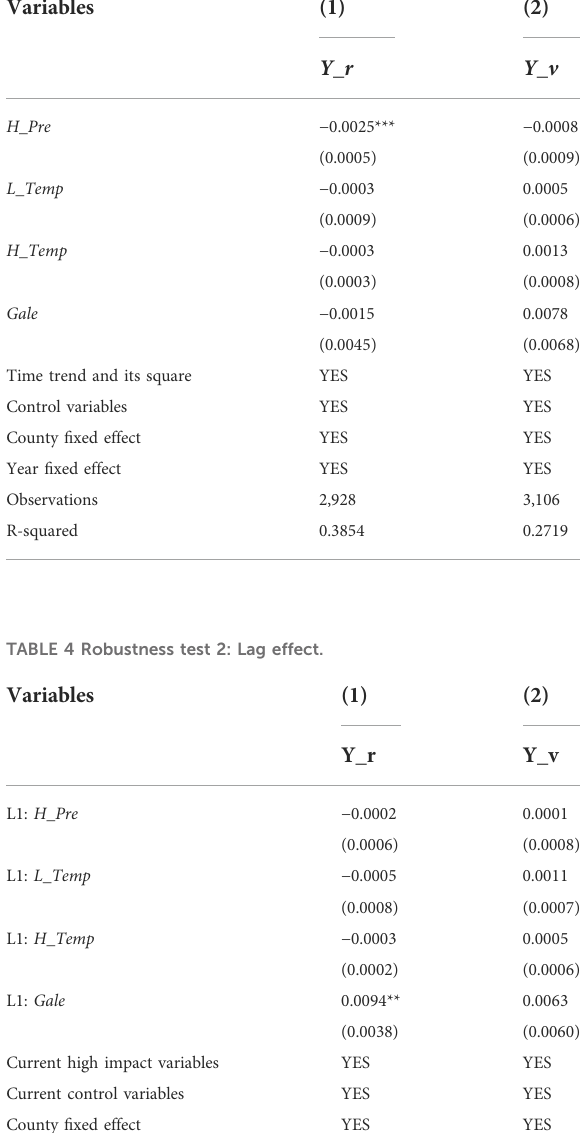
TABLE 3 Robustness test 1: Nonlinear regression results.